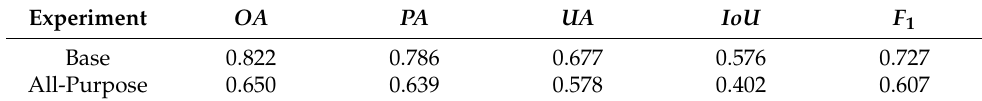
Table 20. Global metrics for the experiment with UNet with simplified classes on UOS2. Experiment